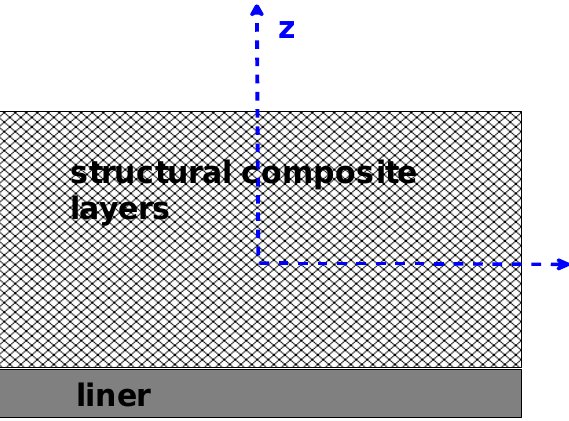
Figure 3. Composition of wall thicknesses of composite pressure vessels.